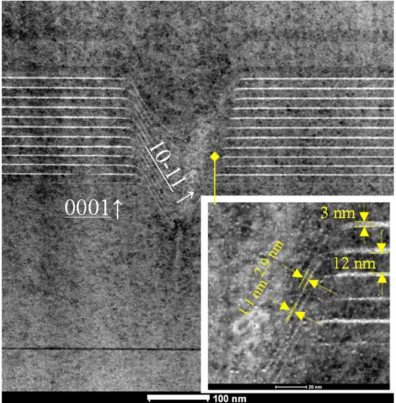
Figure 3. High-resolution Transmission Electron Microscope (TEM) image of a large V-defect, the inset shows the detail of side wall quantum wells (QWs) growth in the V-defect, i.e., the {10-11} plane to c-plane QW transition